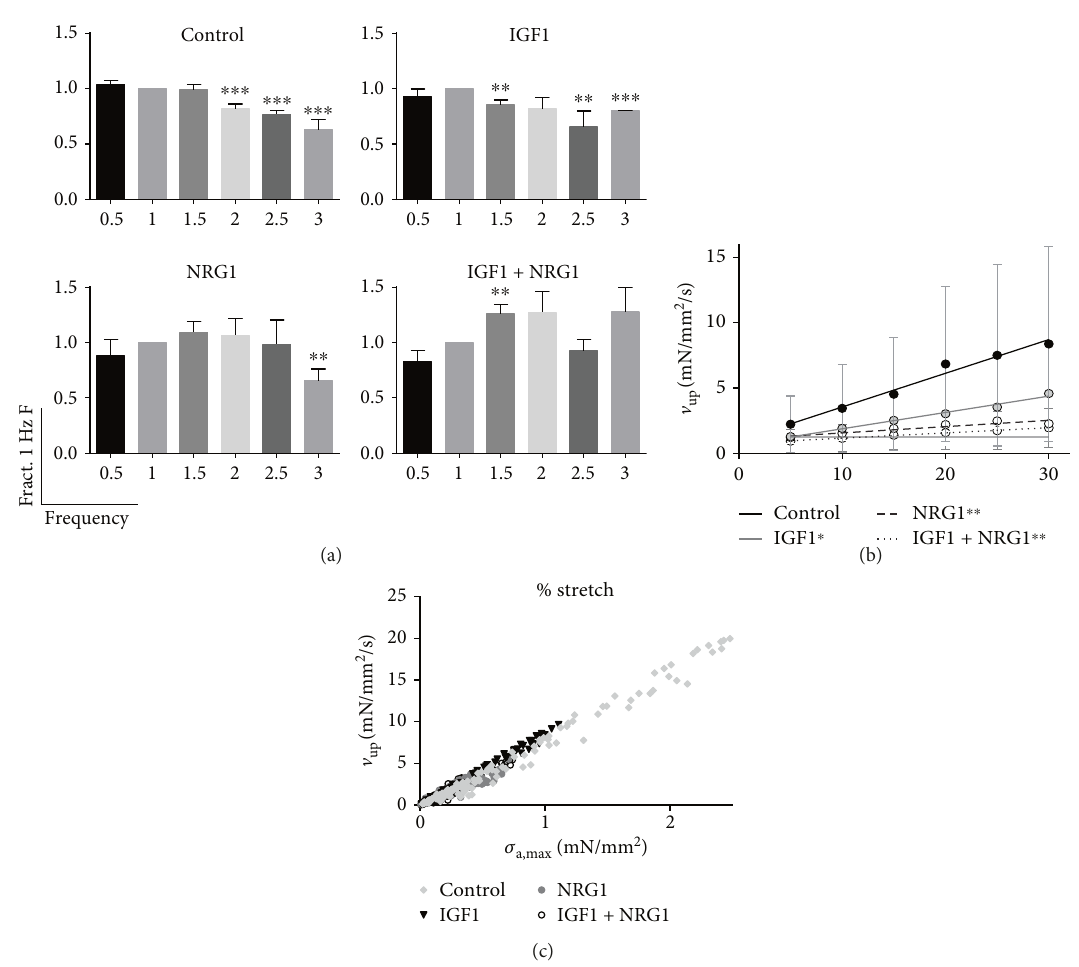
Figure 3: Engineered muscle displays a force-frequency response that is sensitive to biochemical stimulation. (a) Maximum active stress at 30% stretch was measured at increasing frequencies for control, IGF1, NRG1, and IGF1+NRG1. Data are shown normalized to active stress at 1Hz and expressed as mean ± SEM. (b) The relationship between upstroke velocity ( v regression line for each treatment group. Data are expressed as mean ± SEM at each length. (c) A scatterplot of v active stress, σ , was plotted. n = 10 per group. ∗ P < 0 05 , ∗∗ P < 0 01 , and ∗∗∗ P < 0 001 versus 1Hz of the same group (a) or slope of a,max the line versus control